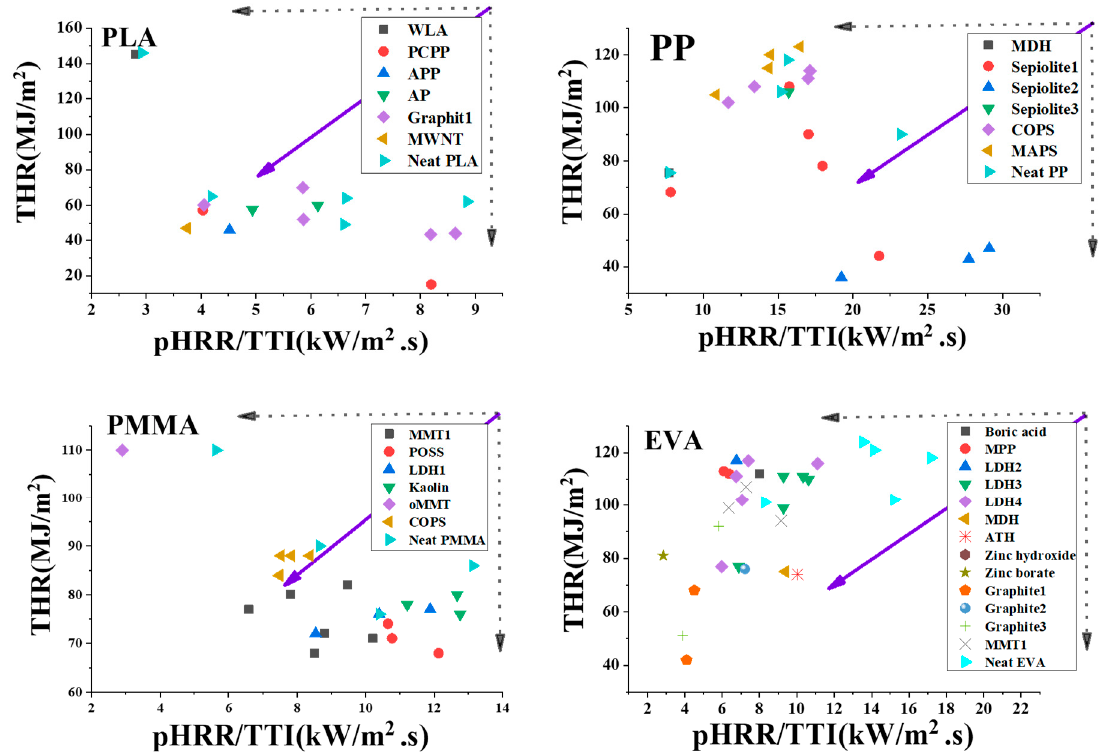
Figure 2. The plots of THR (MJ/m 2 ) against pHRR/TTI (kW/m 2 .s) values obtained from cone calorimetry data with mauve arrows signifying improvement in flame retardancy performance for PLA, PP, PMMA, and EVA thermoplastic composites containing bewildering arrays of additives.